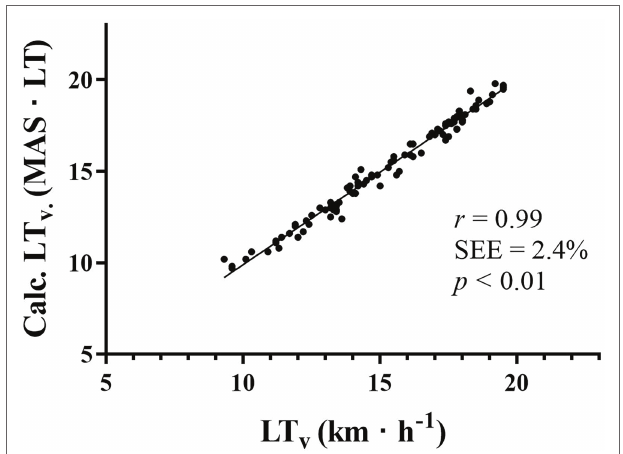
FIGURE 4 | Correlation between LT v at post-test measured by blood lactate and calculated LT v . LT vpost , velocity at lactate threshold at post-test. LT v pred., calculated LT v by a new MAS and LT from pre-tests. km·h − 1 , kilometers per hour; r , correlation coefficient; and SEE, standard error of the estimate in percentage.